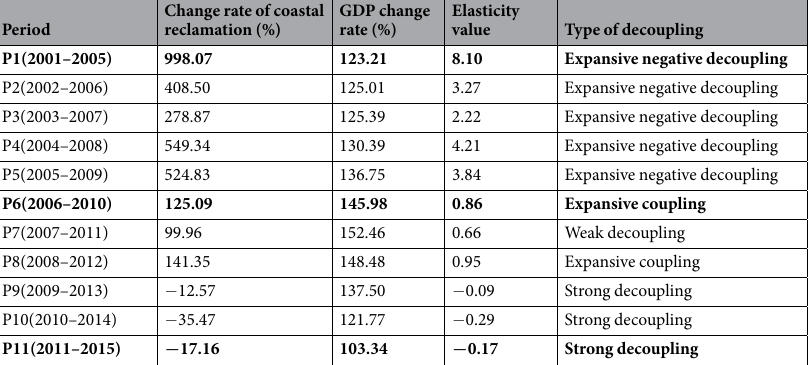
Table 2. Table of the decoupling model. Note: Data in the three main periods (e.g. 2001–2005, 2006–2010 and 2011–2015) are shown in bold for the convenience of identifying decoupling change trends in the whole time